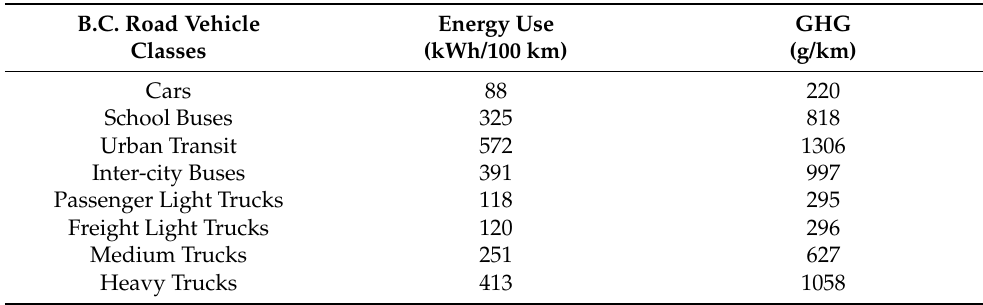
Table 1. Energy use and GHG emissions of road vehicles in B.C. (Average for 1990–2016, except motorcycles)